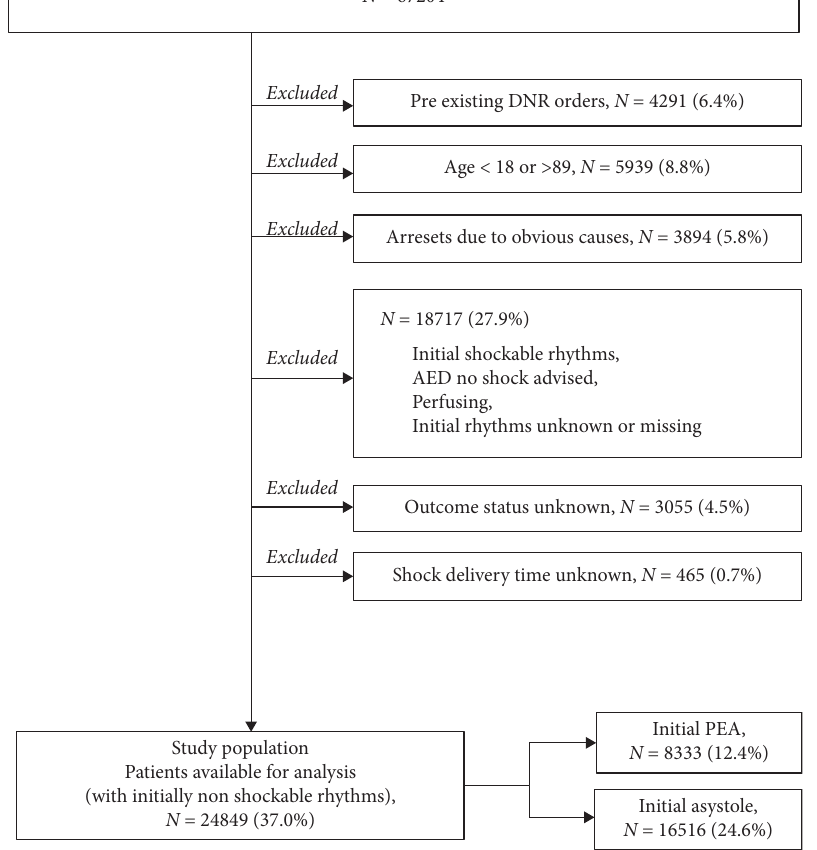
Figure 1: Study population selection process. EMS, Emergency Medical Services; OHCA, out-of-hospital cardiac arrest; ROC, Resuscitation Outcomes Consortium; DNR, do-not-resuscitate; AED, automatic external defibrillator; PEA, pulseless electrical activity; N ,